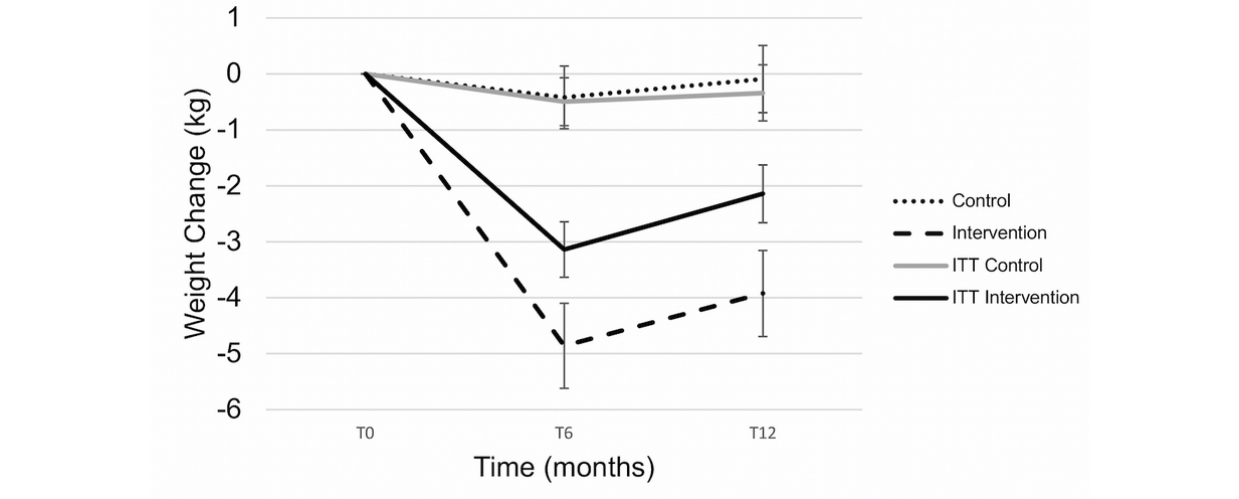
Figure 3. Weight change across time points. ITT: intention-to-treat; T0: baseline; T6: 6 months; T12: 12 months. ITT: intention-to-treat; T0: baseline; T6: 6 months; T12: 12